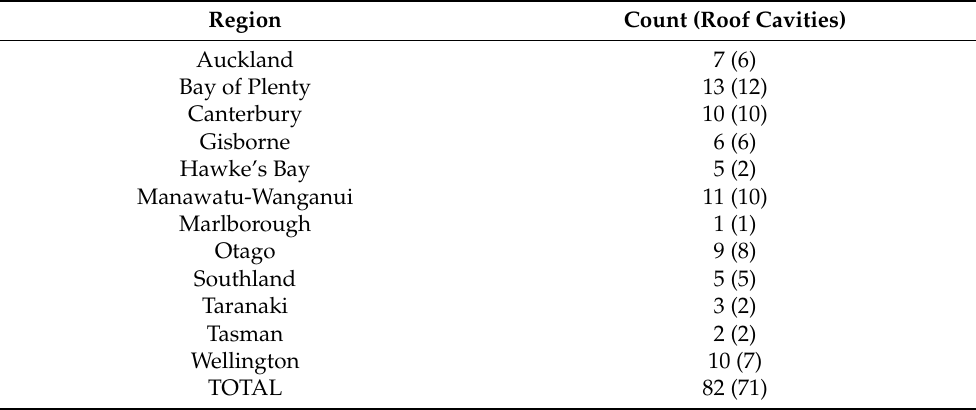
Table 2. Number of dwellings according to the regions across New Zealand used in the PHS study. Not all dwellings had data gathered in the roof